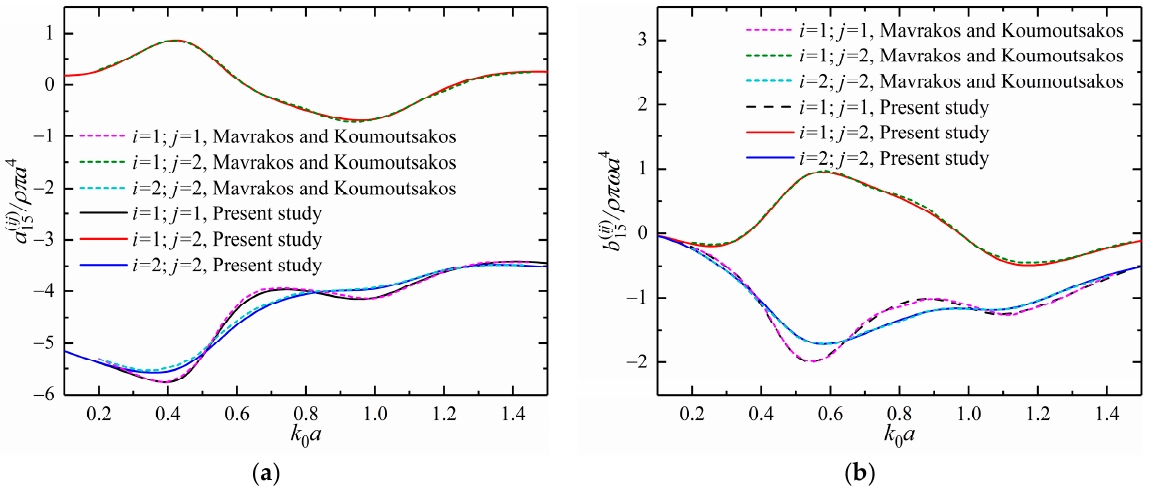
Figure 4. Hydrodynamic coefficients of an array composed of three truncated cylinders: ( a ) added mass; ( b ) added damping.